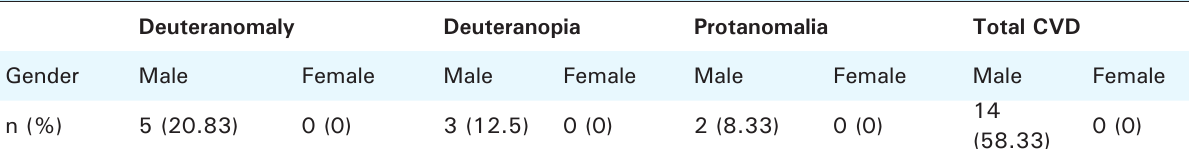
Table 3. Different types of color blindness and their prevalence